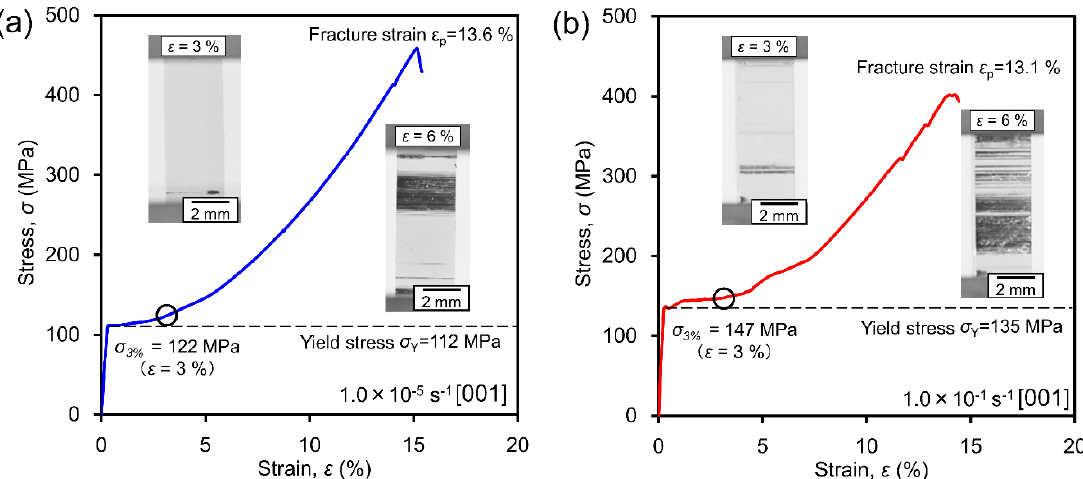
Figure 2. Stress-strain curves and corresponding real-time images captured during deformation for bulk deformation on single crystal SrTiO 3 along the [001] direction: ( a ) Strain rate 1.0 × 10 −5 s −1 ; ( b ) Strain rate 1.0 × 10 −1 s −1 , adopted and modified from [13].